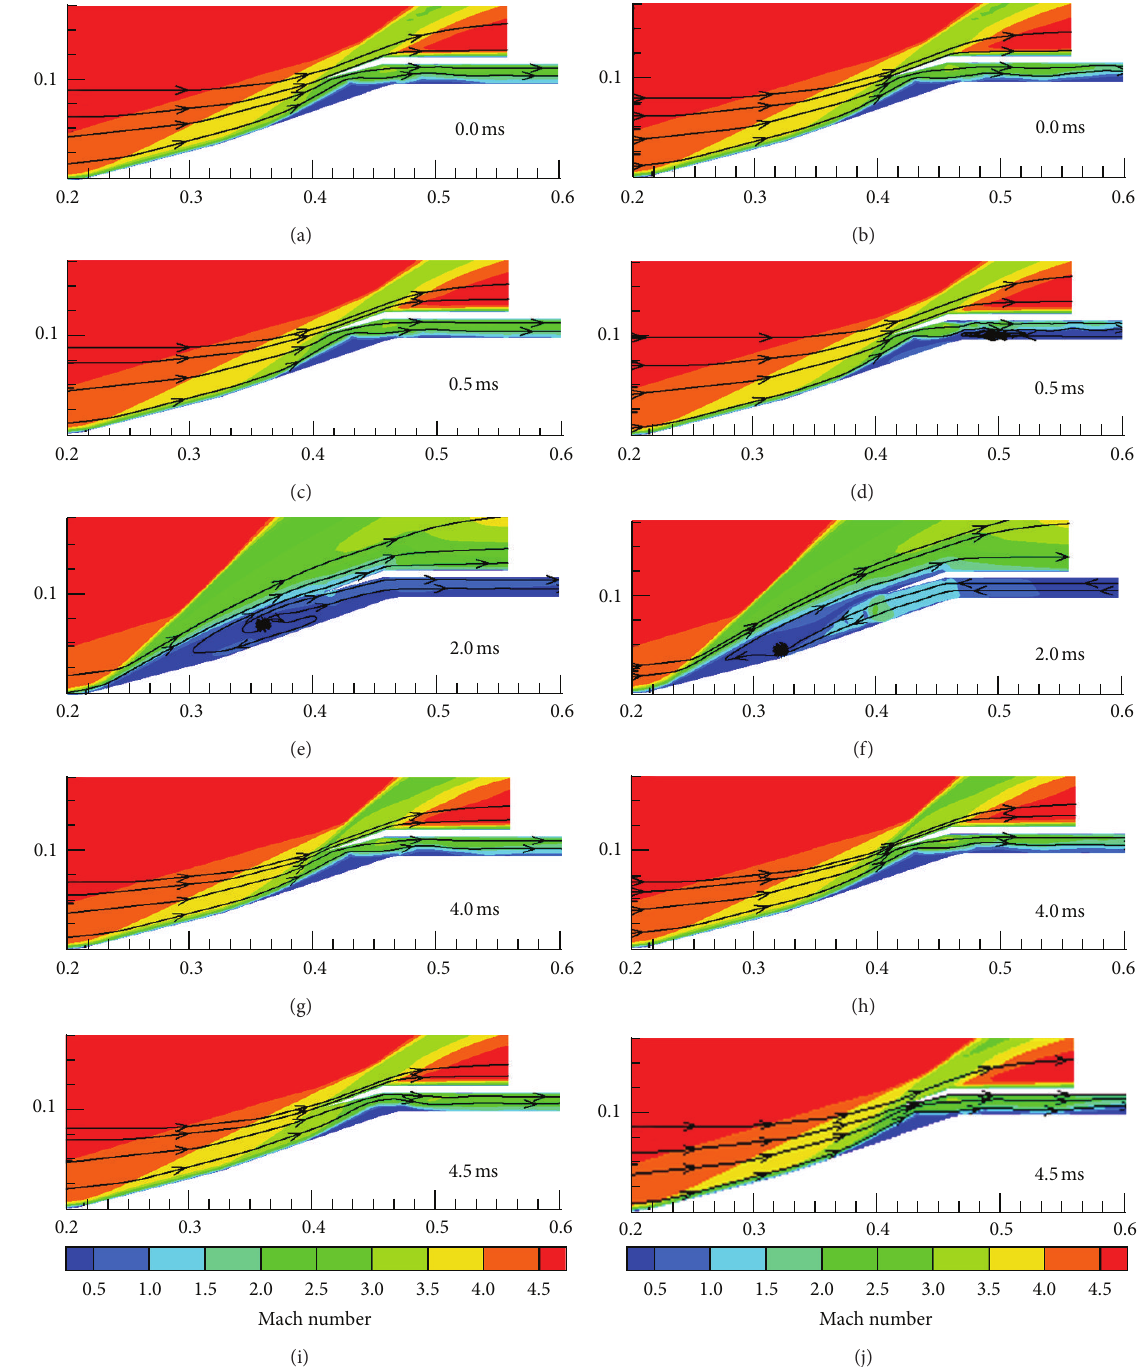
Figure 4: Mach contours mixing with streamlines of cross section 𝑍 1 ( 𝑍 3) and 𝑍 2 in a buzz cycle.